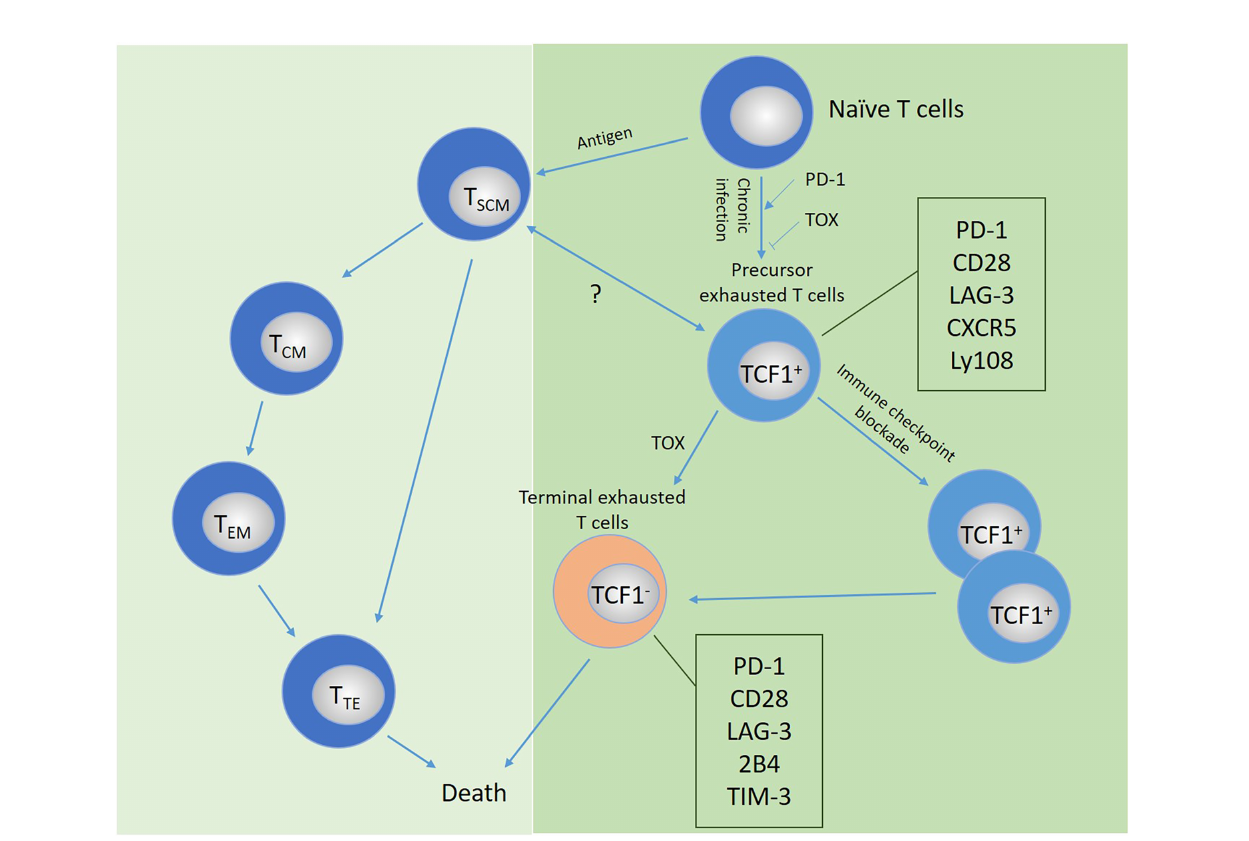
FIGURE 4 | Possible developmental trajectory of exhausted T cells and the comparison and relationship with memory or effector T cells. Under continuous antigen stimulation, T cells transform from precursor exhausted cells into terminally exhausted T cell populations, which mainly depends on the expression of the transcription factor TCF-1, accompanied by the high expression of a variety of inhibitory receptors. The relationship between the differentiation of T cell subsets and exhausted T cells remains to be explored. PD-1, PD ligand 1; TCF1, T cell factor-1; TIM-3, T-cell immunoglobulin domain and mucin domain protein 3; LAG-3, lymphocyte activation gene 3; TOX, thymocyte selection-associated high-motility group (HMG) box